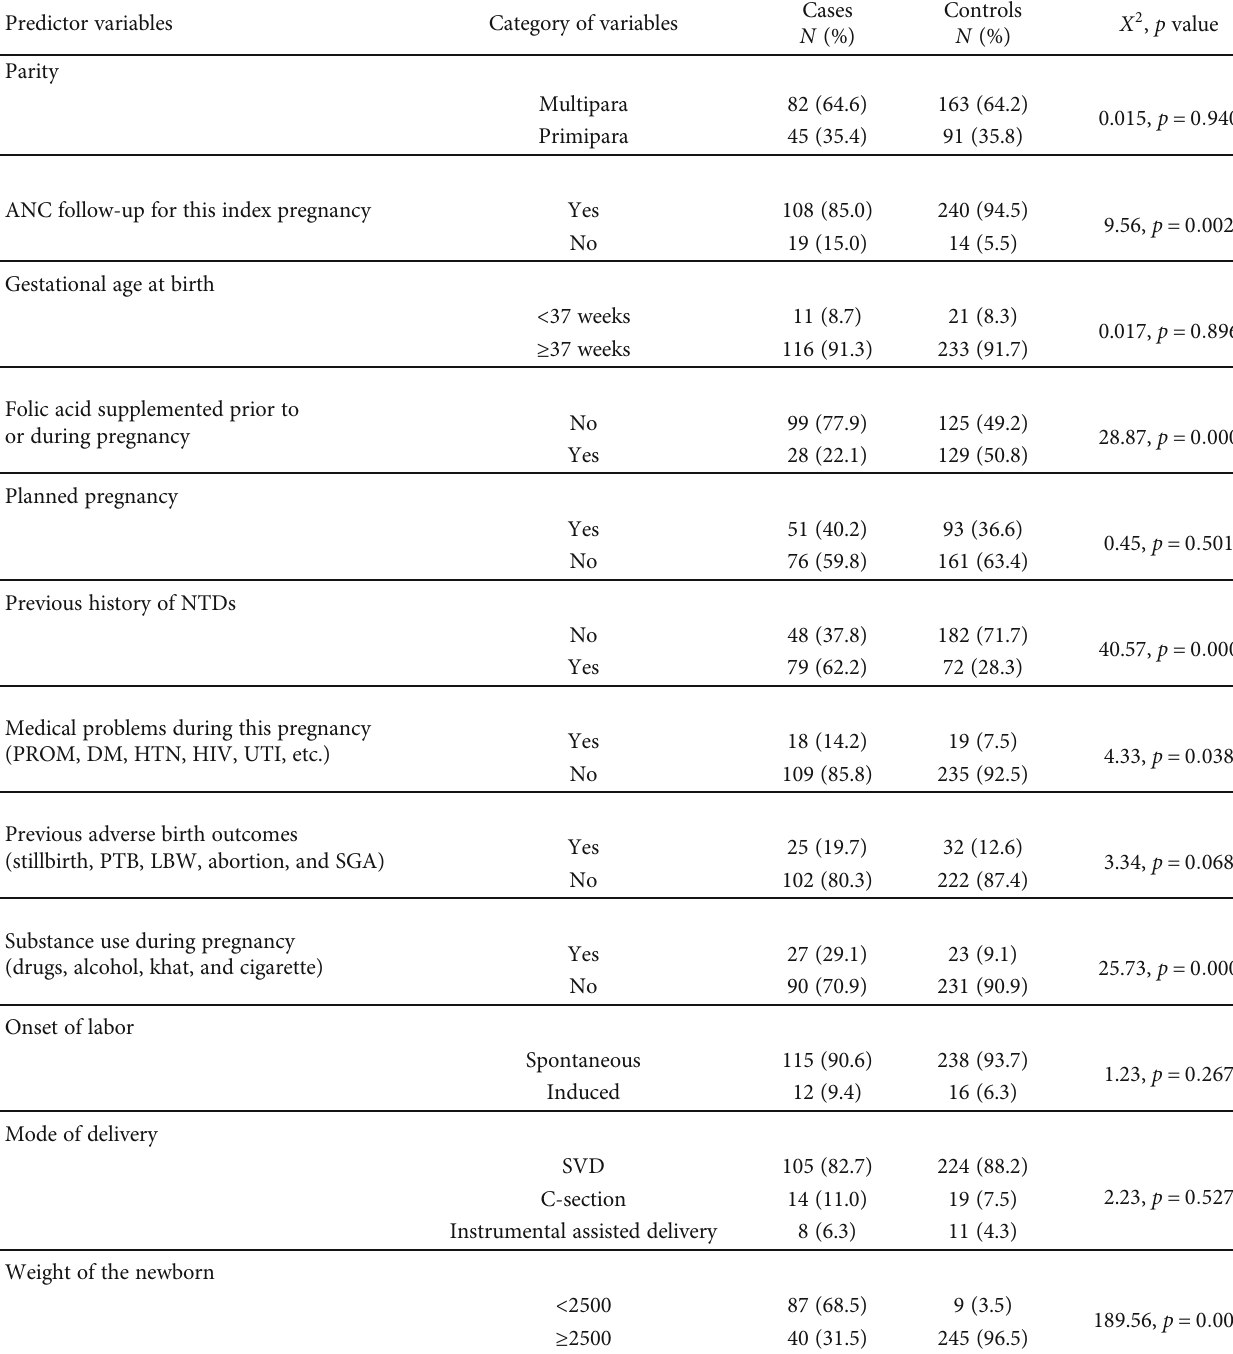
Table 2: The maternal obstetric, behavioral, and newborn-related conditions, Amhara Region, Ethiopia, 2019. Predictor